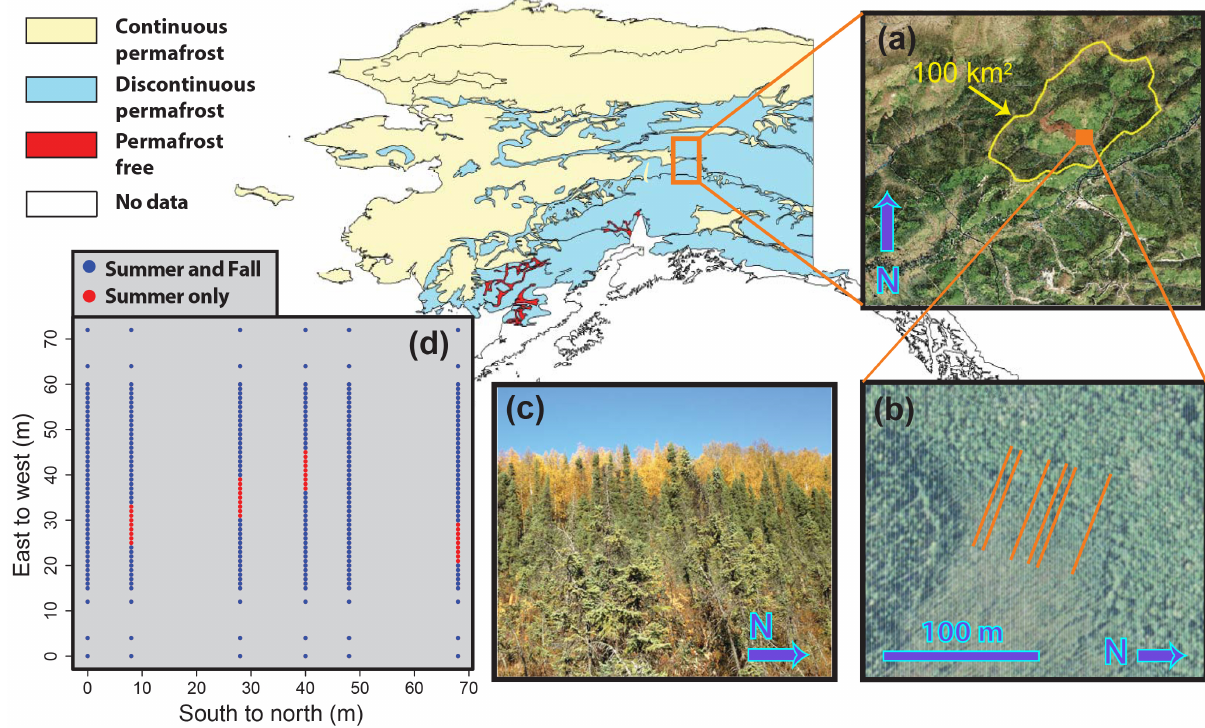
Figure 1. Overview of field site and spatial sampling design. The background map shows the distribution of permafrost across Alaska and indicates the approximate location of the field site. (a) Satellite image showing CPCRW domain outlined in yellow; the orange box shows the location of field sampling. (b) Satellite image of the field site with orange lines indicating transect locations. (c) Picture of the field site looking west (up-slope); gradients in tree size and the transition from black spruce (green leaves) to paper birch (yellow leaves) can be seen. (d) Spatial layout of soil collars with red points denoting collars that were removed after Summer sampling due to soil